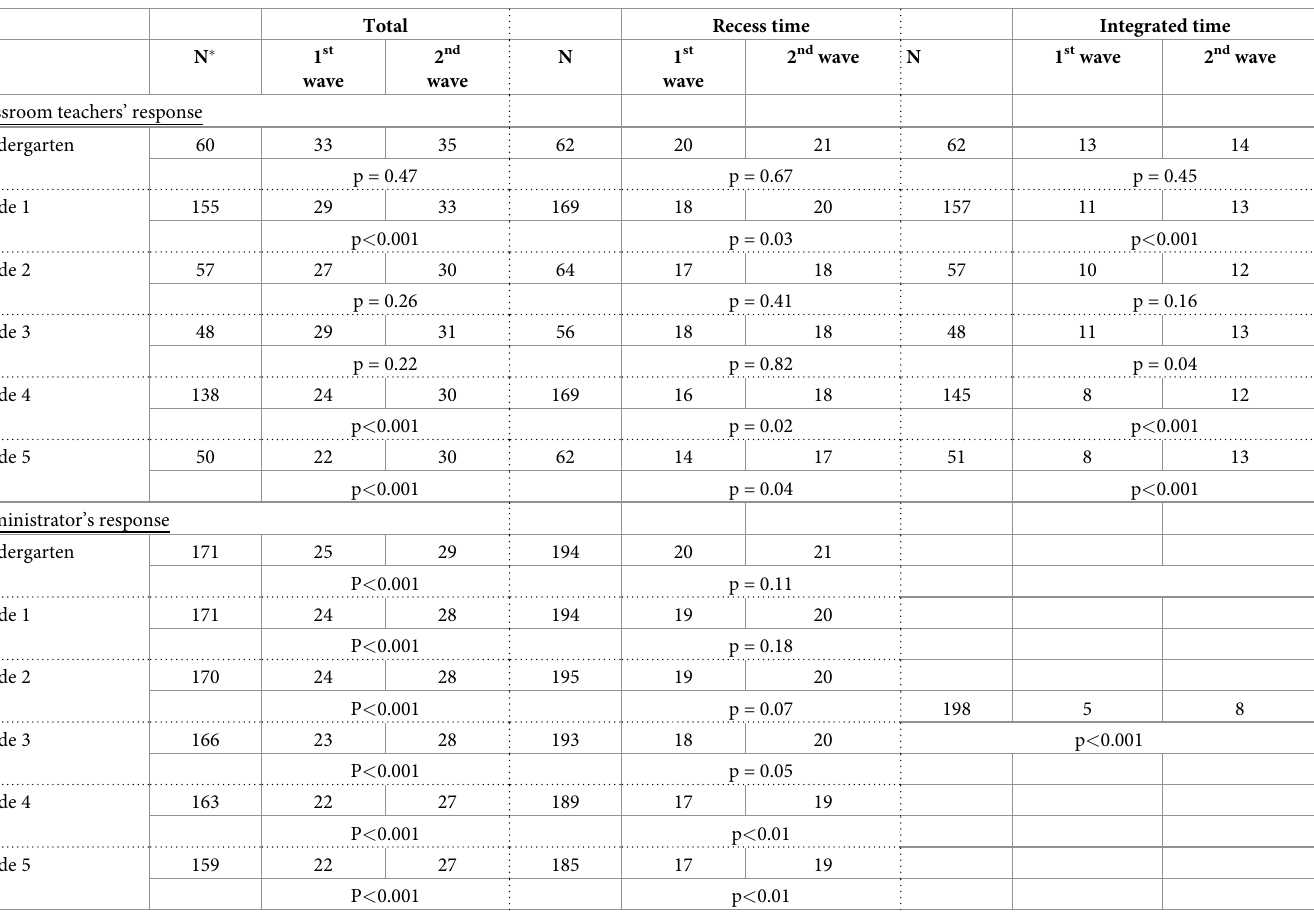
Table 1. Mean recess, integrated and total physical activity (minutes per day) by grade